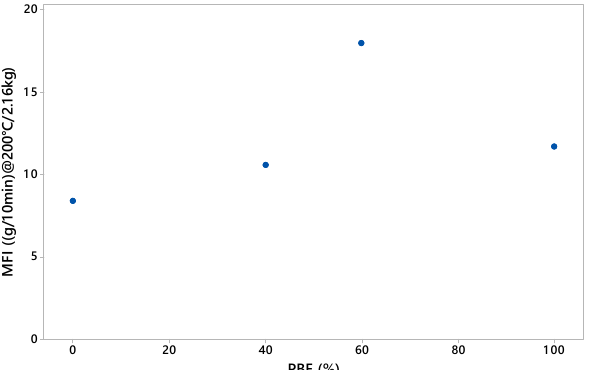
Figure 4. Melt Flow Index (MFI) (200 ◦ C / 2.16kg) values: e ff ect of PBE percentage in LDPE / PBE blends.